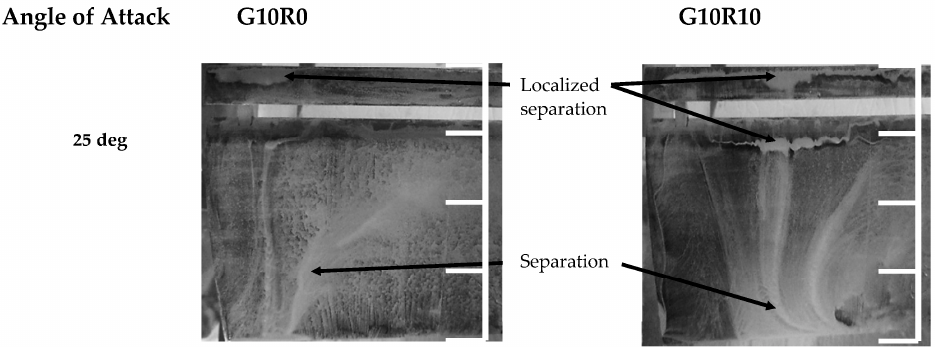
Figure 5. Effect of angle of attack and slat deployment (G10R0 and G10R10 geometry) on surface skin friction patterns. Flow is from top to bottom.